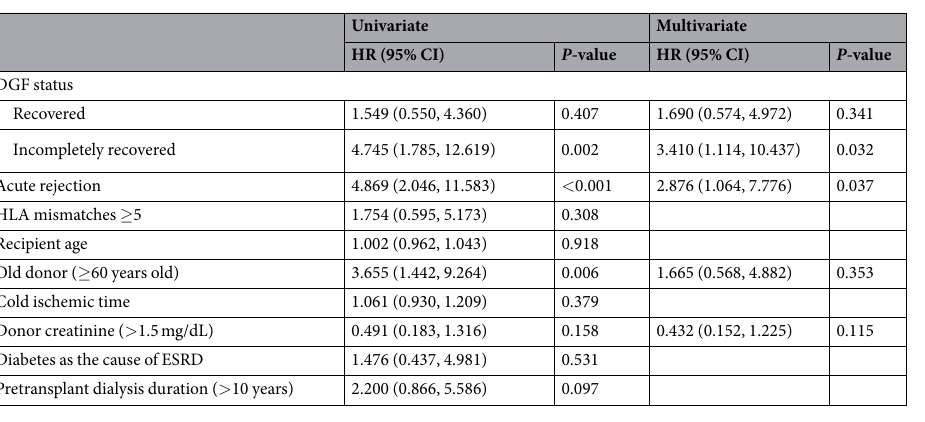
Table 2. Risk factor analysis for death-censored graft failure. DGF = delayed graft function, ESRD = end stage renal